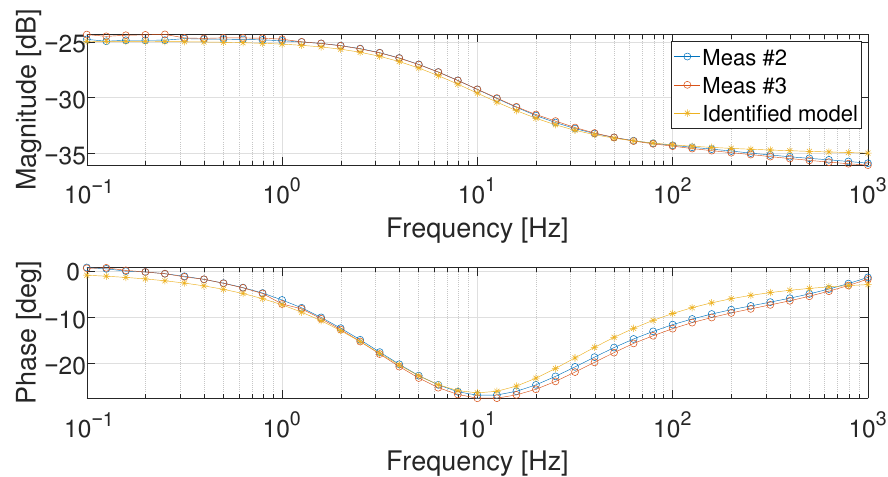
Figure 11. Bode diagrams of the identified Meas #1 at 1A and compared with Meas #2 and Meas #3 .